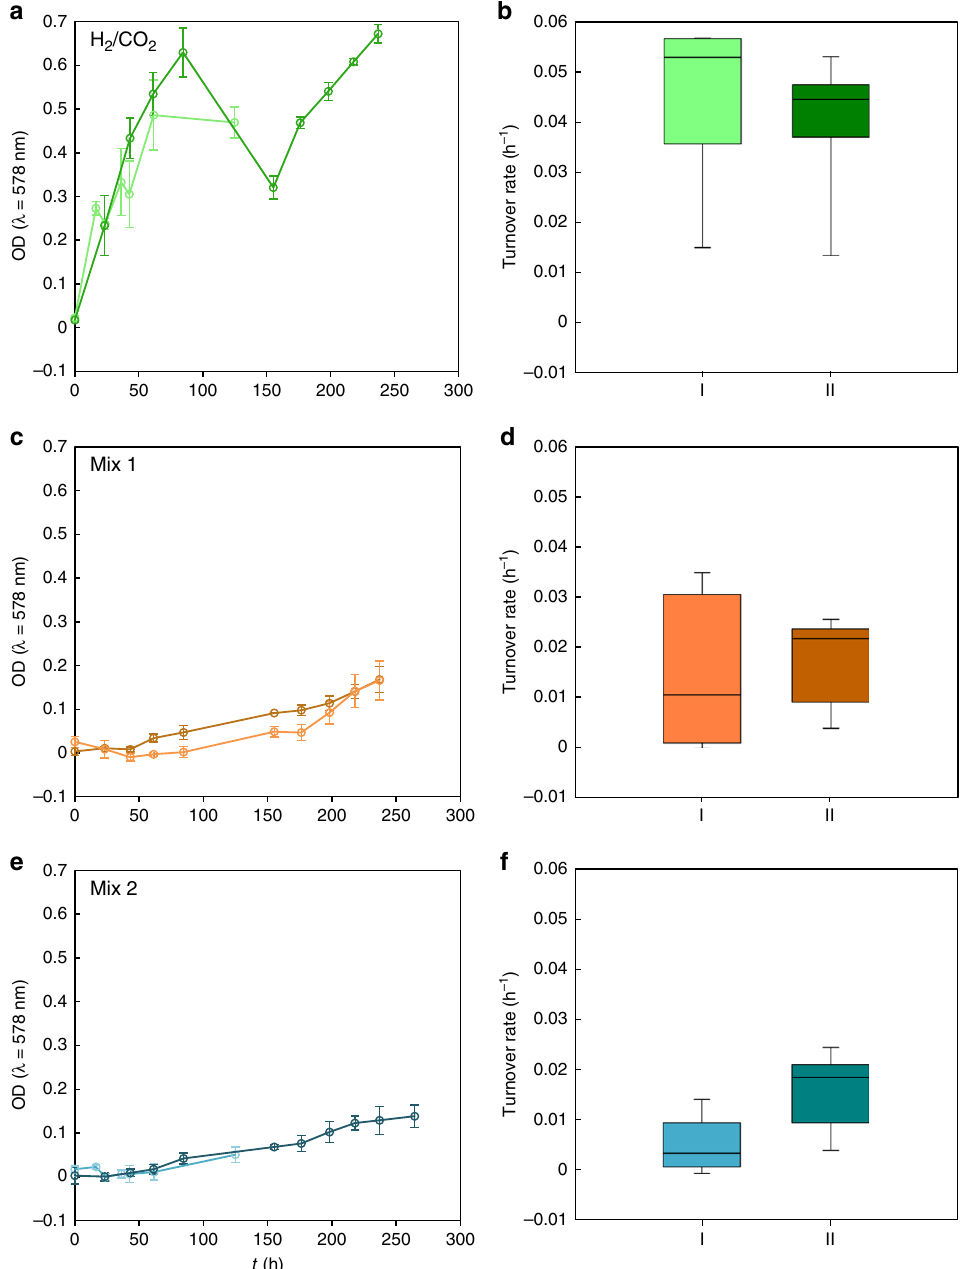
Fig. 3 Growth and turnover rate of M. okinawensis under Enceladus-like conditions at 2 bar. a , c , e Growth curves (OD 578nm ) and b , d , f turnover rates (h − 1 ) as a measure of CH 4 production of M. okinawensis on a , b H 2 /CO 2 (4:1), c , d Mix 1 and e , f Mix 2. For detailed composition of gases and media see Table 2 and Supplementary Table 3. I and II (light and dark colours, respectively) denote two independent experiments (each performed in triplicates, error bars = standard deviation). Enceladus-like concentrations were used for NH 4 Cl and CH 3 OH and mean liquid inhibitor concentrations determined in the DoE were used for CH 2 O. The dip in a was caused by substrate limitation due to depletion of serum bottle headspace of H 2 /CO 2 at high-optical cell